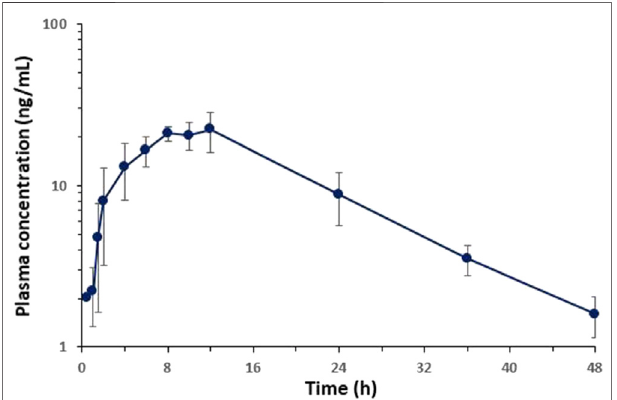
FIGURE 4 | Average plasma concentration-time pro fi les ofBCP vs. time obtained after topical application of hydrogel containing 0.1% of BCP in rats ( n (cid:1) 5).